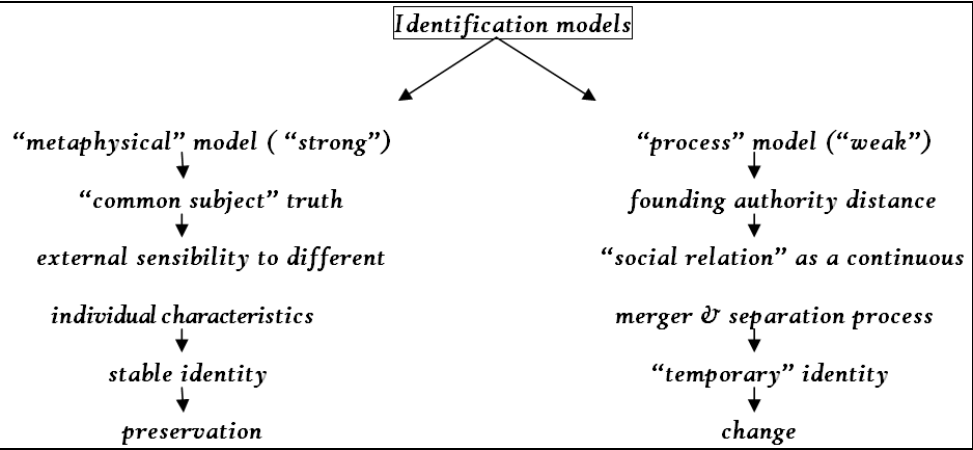
Figure 5: Organization and Identification Models